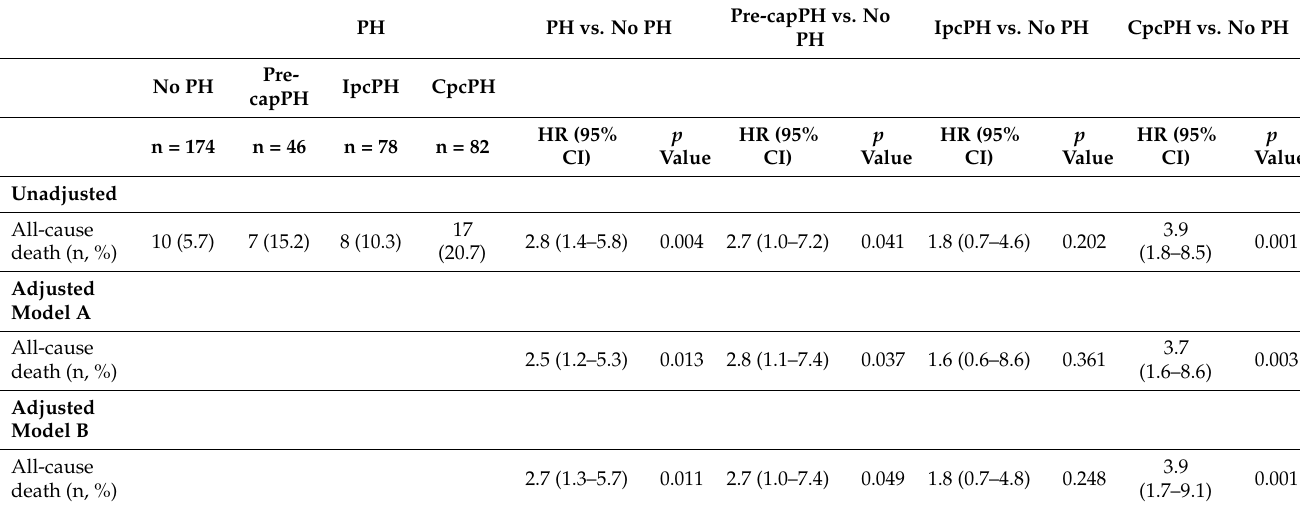
Table 6. Unadjusted and adjusted all-cause mortality rates at 1